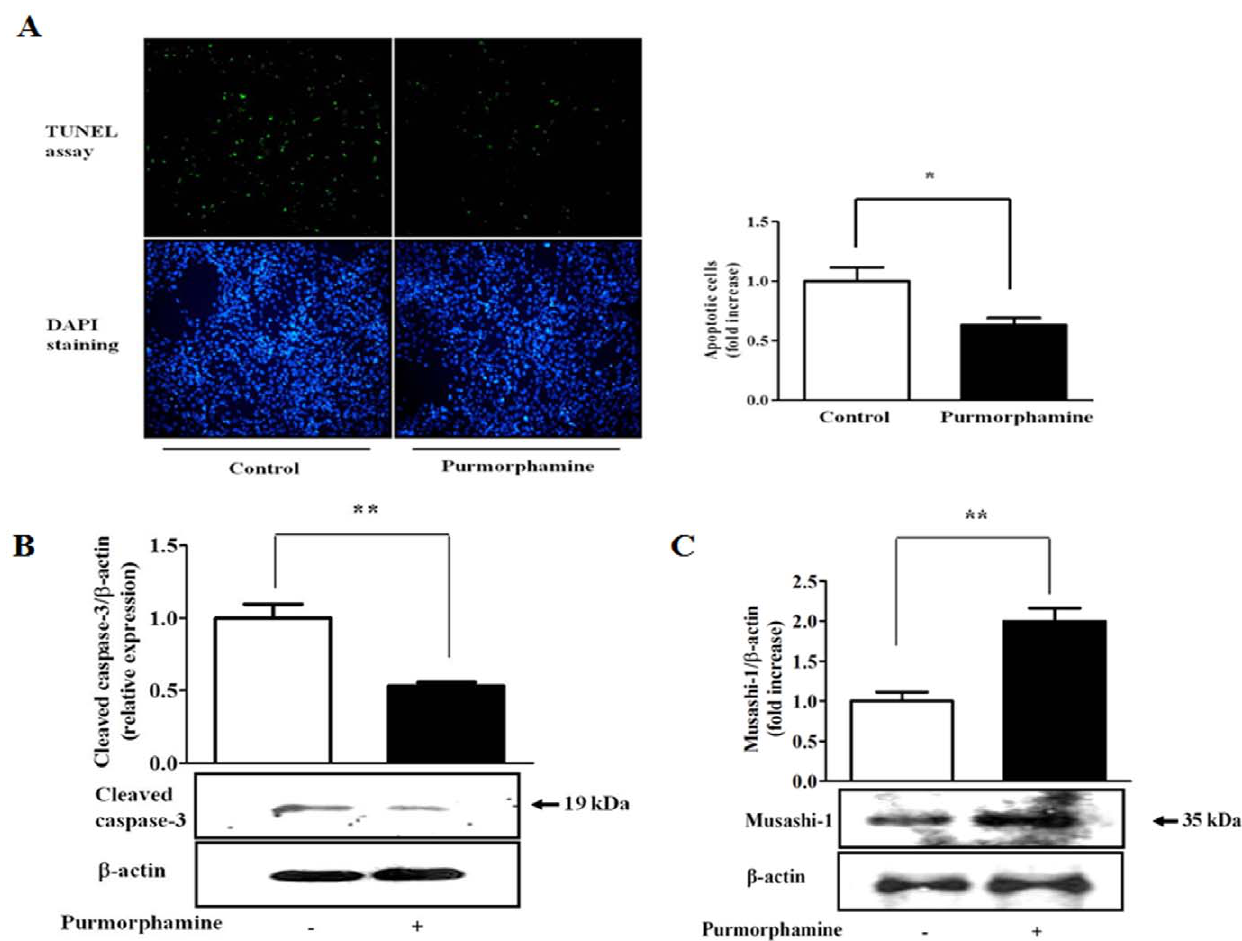
Figure 2. Hedgehog stimulation suppresses apoptosis through the activation of Msi1. hUCB-MSCs were cultured in serum-free medium and then treated with or without purmorphamine (4 m M). Apoptotic levels were assessed with a TUNEL assay and western blotting. Apoptotic cells were quantified by counting the number of TUNEL-positive cells. Purmorphamine treatment for 72 h significantly decreased the number of TUNEL- positive cells ( A ) and the expression level of cleaved caspase-3 ( B ). The blue staining (DAPI) identifies cell nuclei. ( C ) The expression level of Msi1 was assessed by western blot. 4 m M purmorphamine treatment for 72 h significantly increased Msi1 expression. b -actin was used as an internal control. The results are shown as the mean 6 SD from three independent experiments. * P , 0.05, ** P , 0.01, and *** P ,